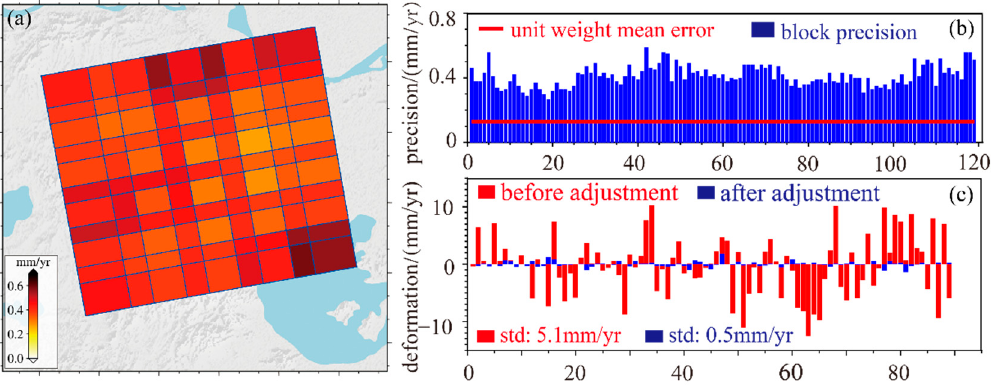
Figure 6. ( a ) Deformation precision of each block after adjustment in Changzhou. ( b ) The histogram of the adjustment precision of each block after adjustment, ( c ) the histogram of the difference of the mean value of the overlapping area before and after adjustment of each block.